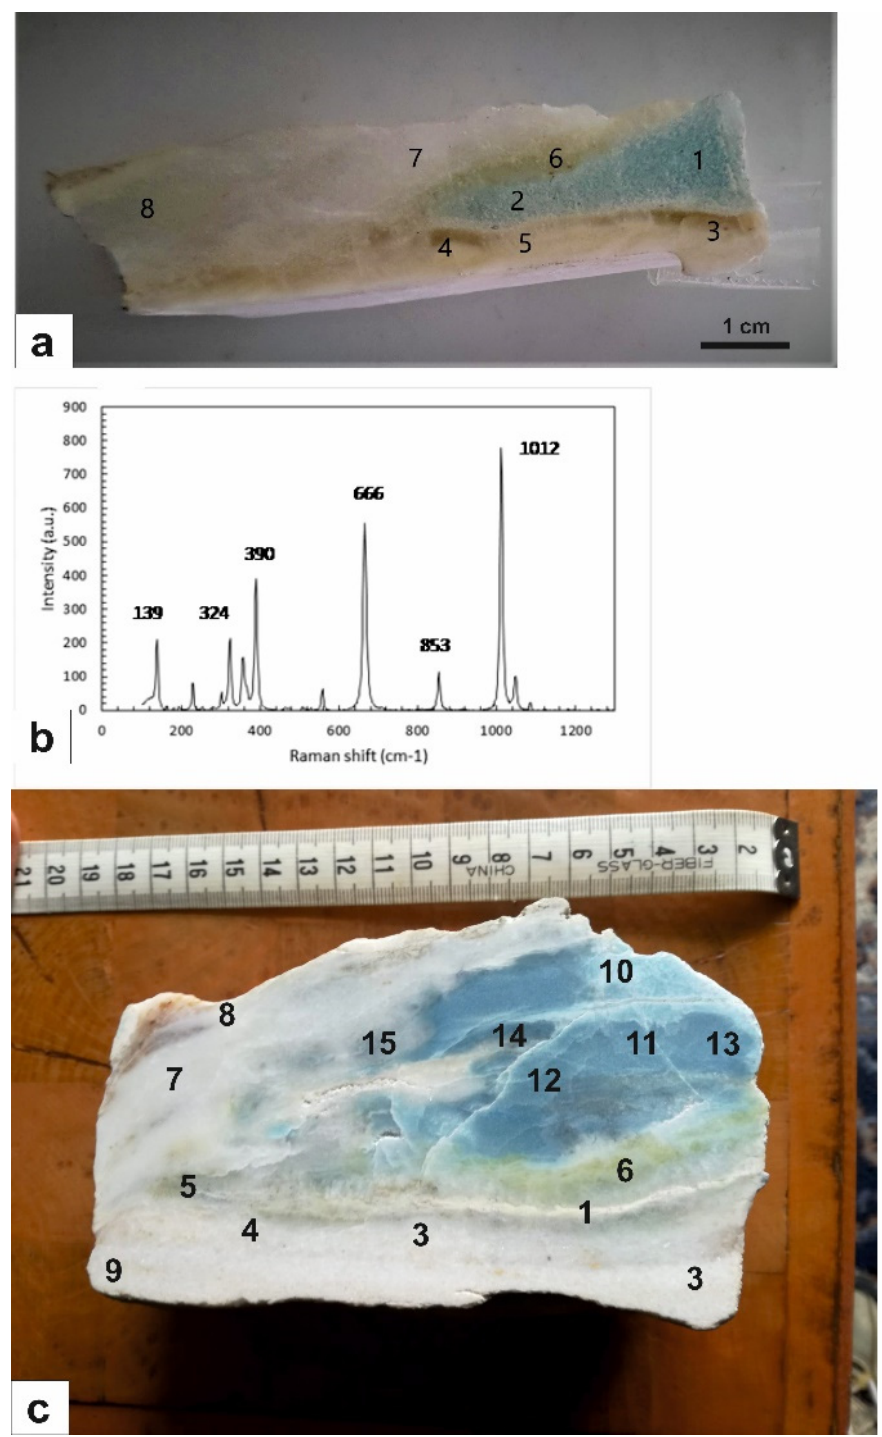
Figure 13. ( a ) Sample from the right side of the valley, showing the points analyzed by Raman spectroscopy: points 1 and 2 = diopside; points 3, 4 and 6 = lizardite; point 5 = calcite; points 7 and 8 = forsterite; ( b ) Raman spectrum of the studied diopside; ( c ) sample from the left side with the analyzed points: point 1 = dolomite; points 2, 3, 4, 7, 8, 9, 15 = calcite; points 10, 11, 12, 13 = diopside; point 14 = tremolite; point 5 = forsterite; point 6 = lizardite. The spectra of the diopside from theSissone valley are characterized by two intense bands corresponding to the Si–O nbr stretching mode (1012 cm − 1 ) and to the stretching of Si–O br bonds (664–666 cm − 1 ) (Figure 13b; Table 6). In the 500–560 cm − 1 region there are